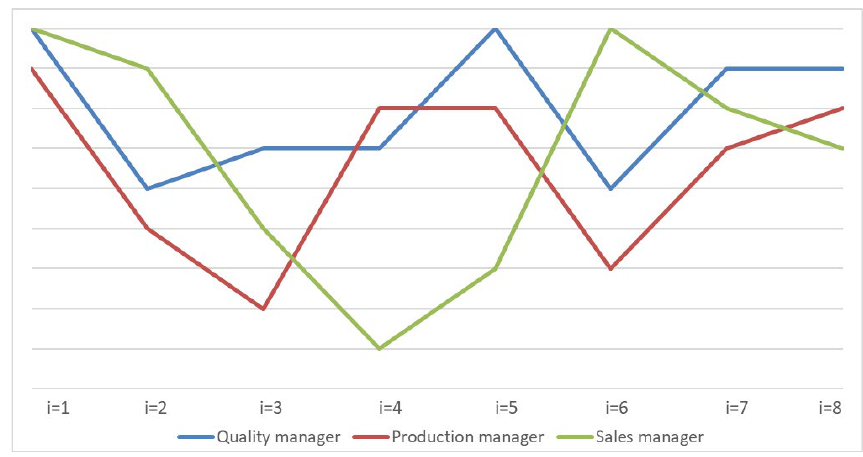
Figure 2. Assessment of the relative importance of performance indicators. The aggregation of DMs opinions into the unique mark is given by IVIFWG. The nor- malized weights of PIs are given by using the proposed procedure [36,37]. The calculated values are presented in Table 6. Table 6. The aggregated relative importance of performance indicators. The Aggregated Relative Importance of PIs